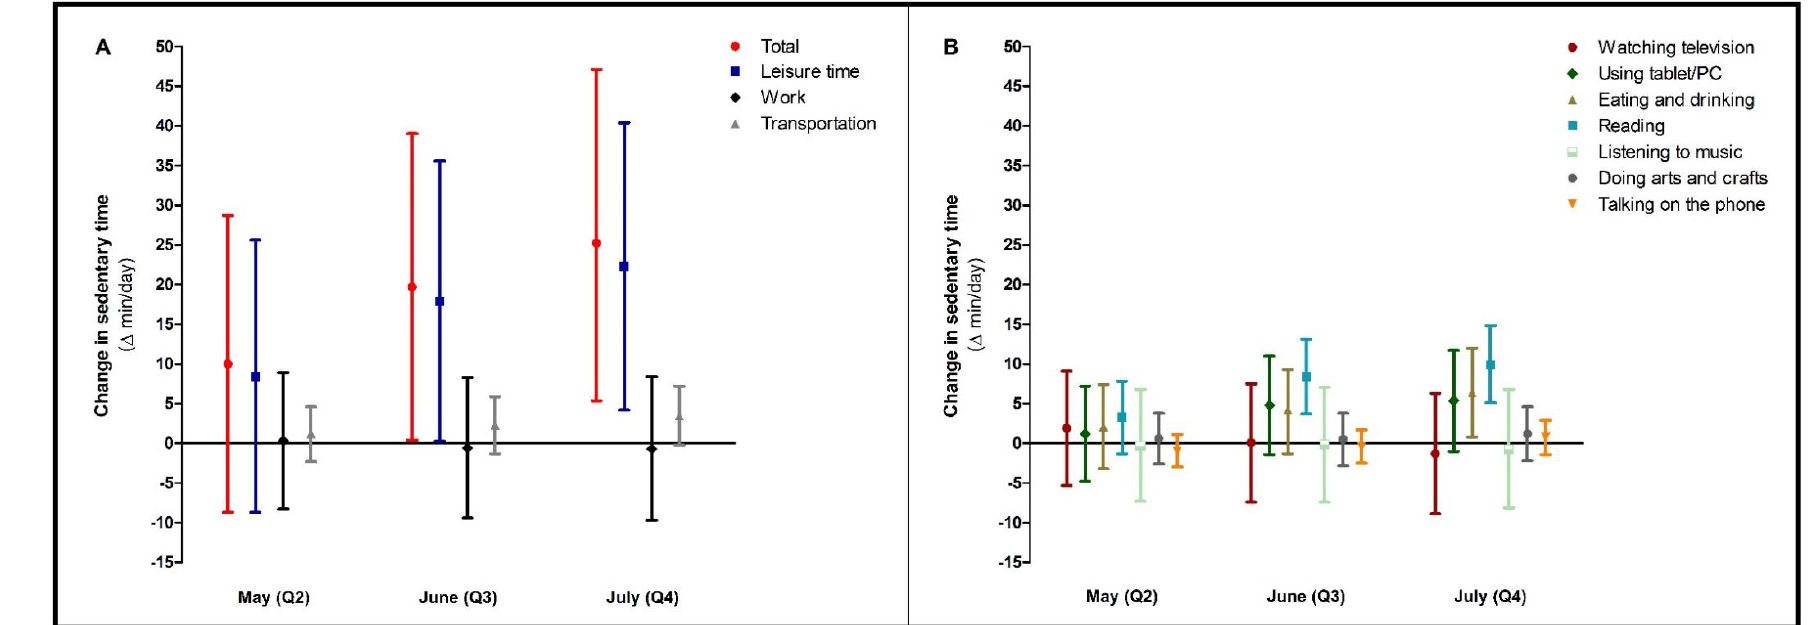
Figure 4. Changes in sedentary time (total and per different setting, ( A )) during the COVID-19 lockdown period. In ( B ), changes in the different sub settings of leisure time sitting were specified. Data were reported as ∆ (95% confidence interval) for follow-up measurements (Q2, Q3, Q4), with baseline (Q1) as reference category. Values were based on final multivariate mixed model analysis, adjusted for confounding factors.